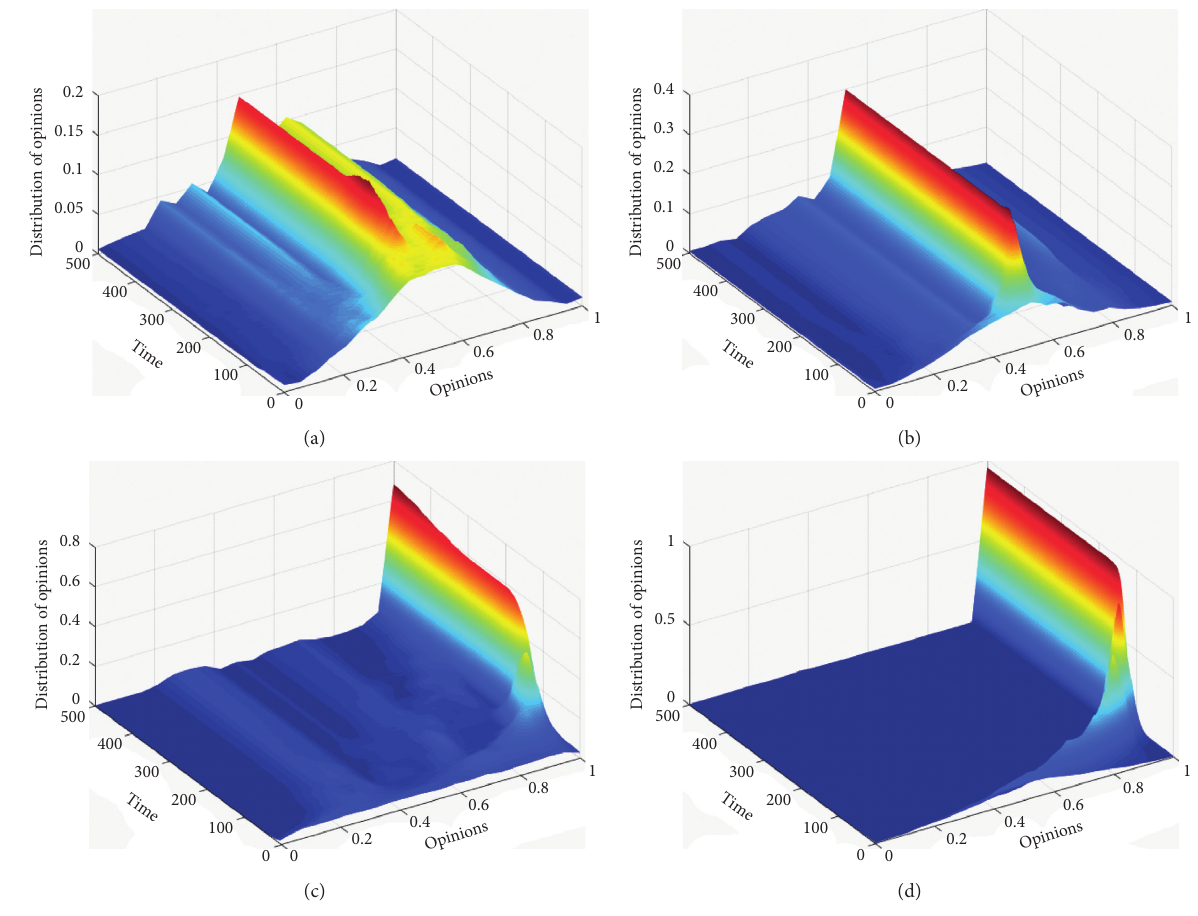
Figure 5: Group opinion distribution evolution under the normal distribution of the initial opinions. Compared with the random distribution of the initial opinions, the value of d m is lower when group polarization is formed under the normal distribution of the initial opinions. (a) d m � 0 . 1. (b) d m � 0 . 15. (c) d m � 0 . 2. (d) d m � 0 . 3.